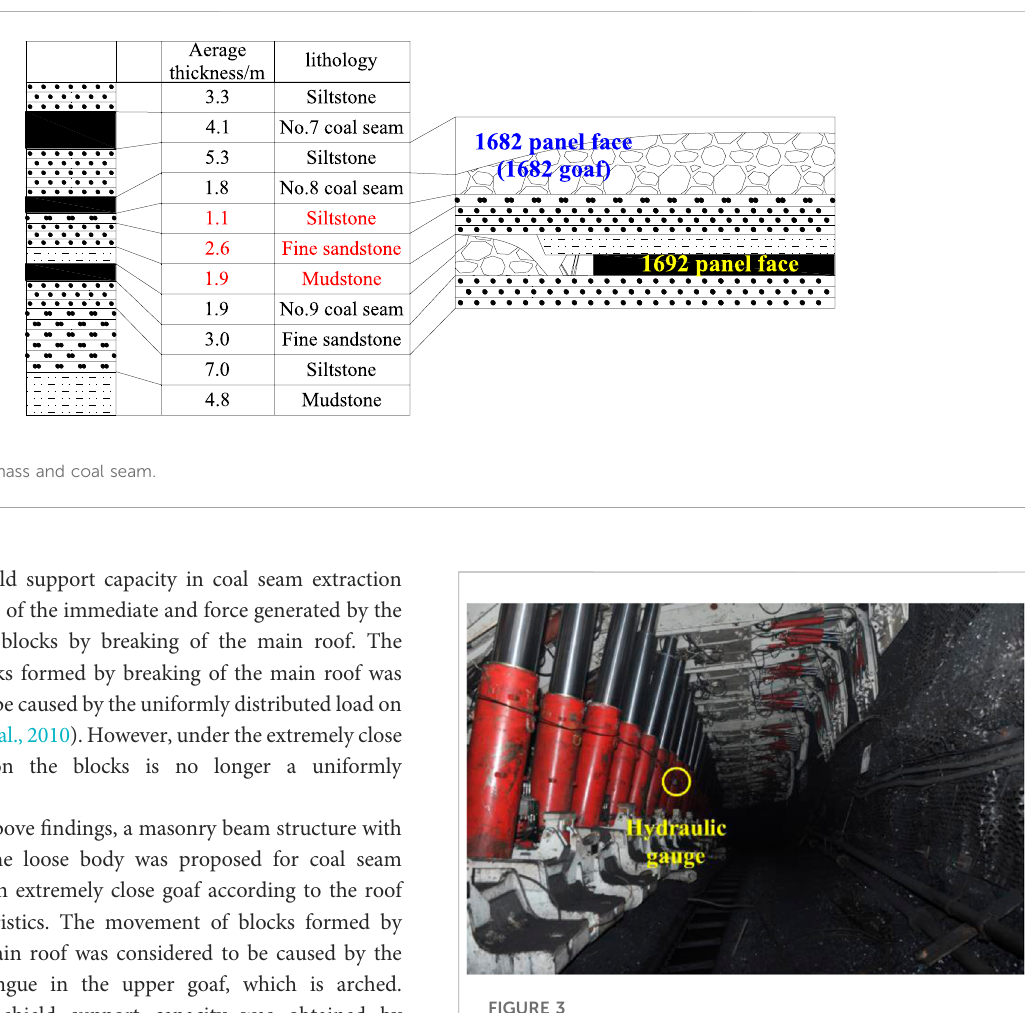
FIGURE 3 ZY4800-13/32 hydraulic